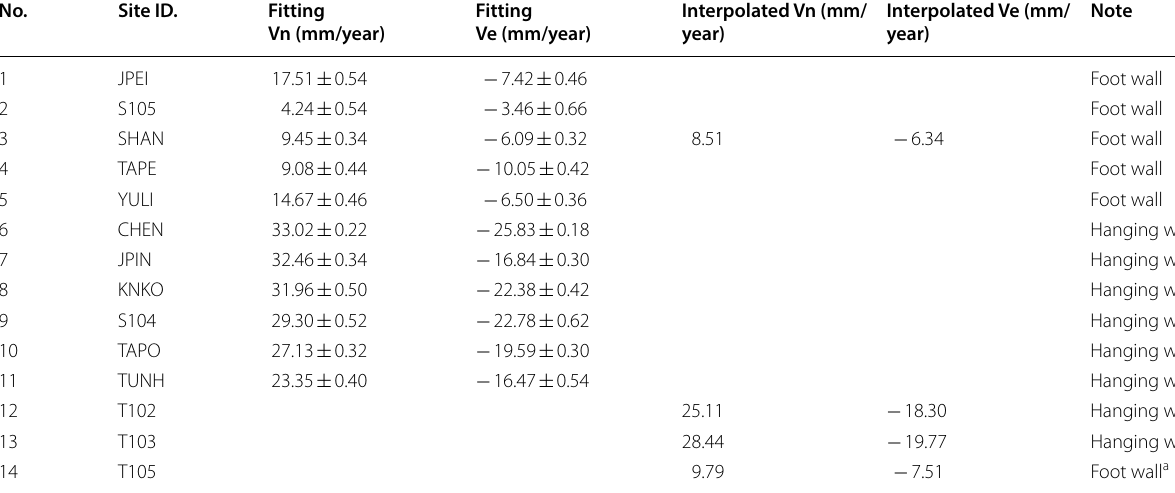
a No preseismic data